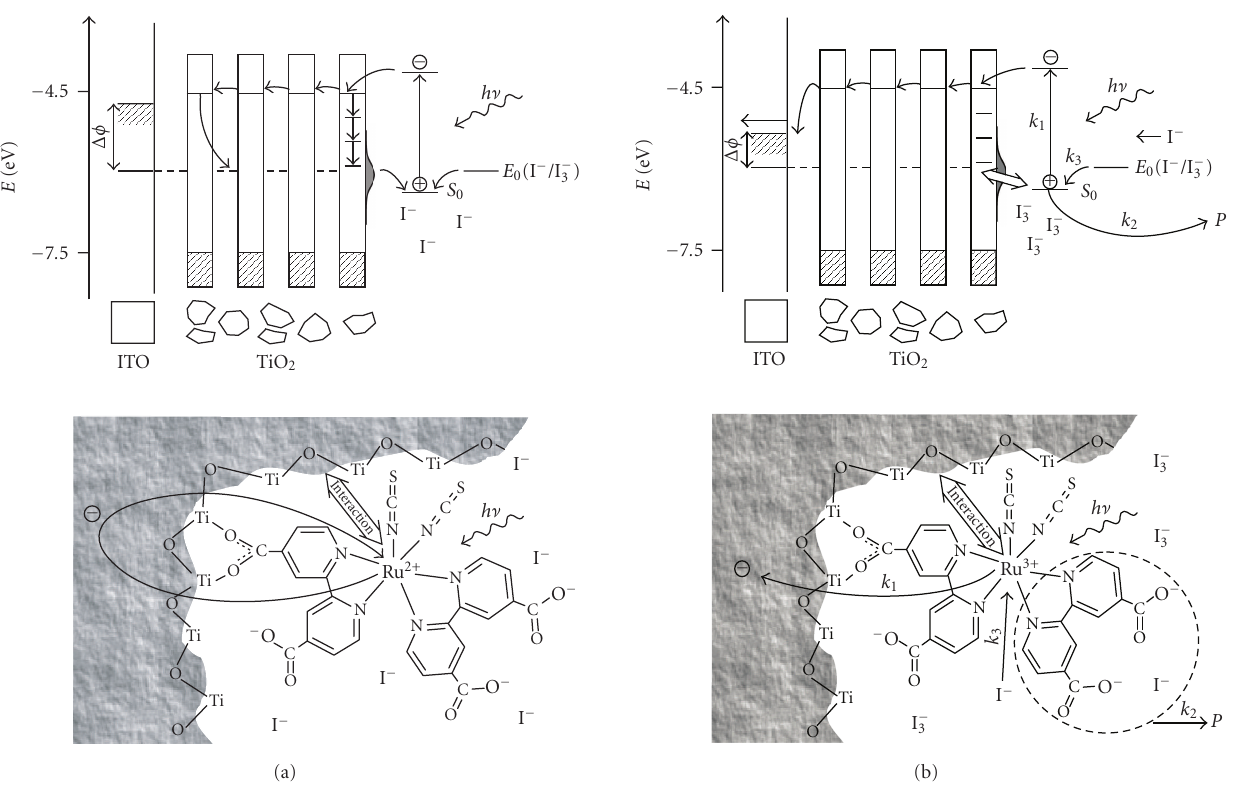
Figure 10: Compares the N3 ruthenium complex, both, in the state of rapid electron recovery (Figure 10(a)) and in the state of electron extraction via a reasonably high photocurrent flow (Figure 10(b)). While present in the TiO 2 interphase, the injected electron may convert Ti 4+ into Ti 3+ enabling a back bonding reaction facilitating a temporary Ti 3+ (ligand)Ru 3+ charge transfer